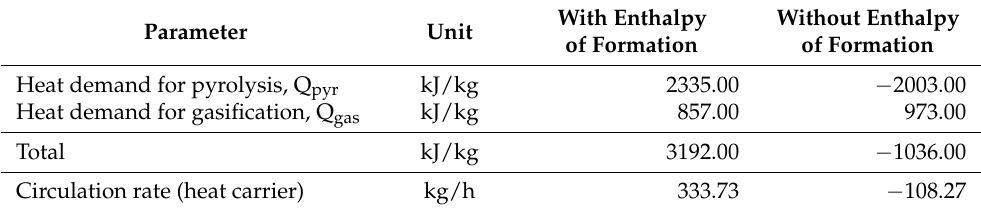
Table 8. Results of thermal effects calculation for biomass pyrolysis and char gasification processes.